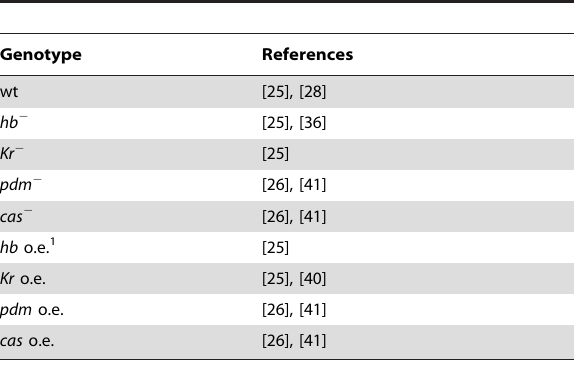
Table 2. List of references for the sequential expression pattern in various